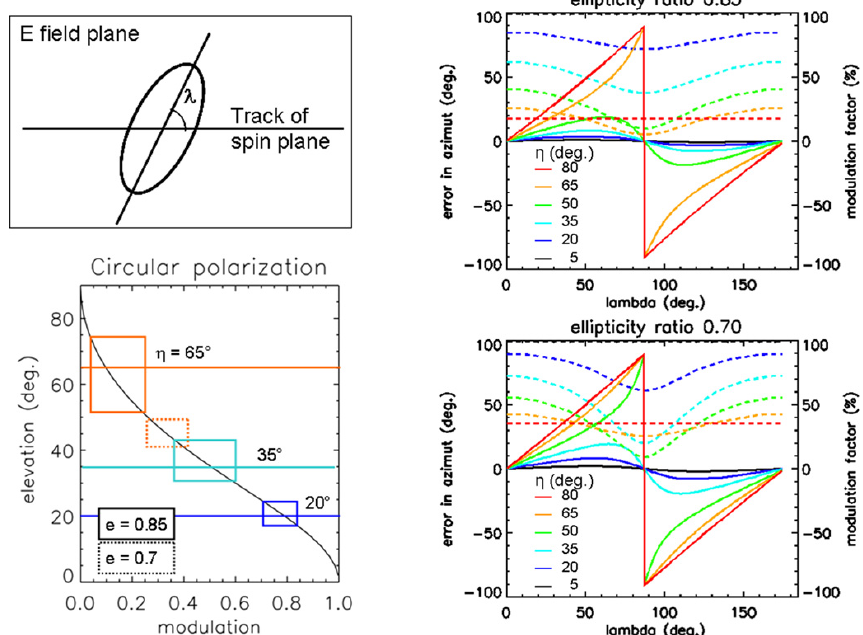
Fig. 5. Top left: sketch of ellipse in electric field plane, displaying the angle λ between the intersection of the ellipse with the spin plane and the major axis. Right: Azimuth error in direction finding as a function of major axis orientation angle λ (solid lines). Two values of ellipticity ratio are examined (top and bottom panels, respectively) and six values of elevation η (indicated by colour codes). Dashed lines show variations with angle λ of measured modulation factor α . Bottom left: the black solid line displays elevation angle η of k vector versus modulation factor α under circular polarization ( e = 1). Rectangles delimit domains of η values derived from measured modulation and assuming e = 1 when e < 1; in solid lines at e = 0 . 85 for three values of η (65, 35 and 20 ◦ ) and in dashed lines at e = 0 . 7 for η = 65 ◦